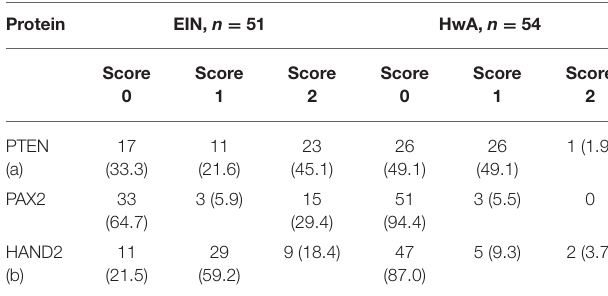
TABLE 3 | Immunoscoring results for PTEN, PAX2, and